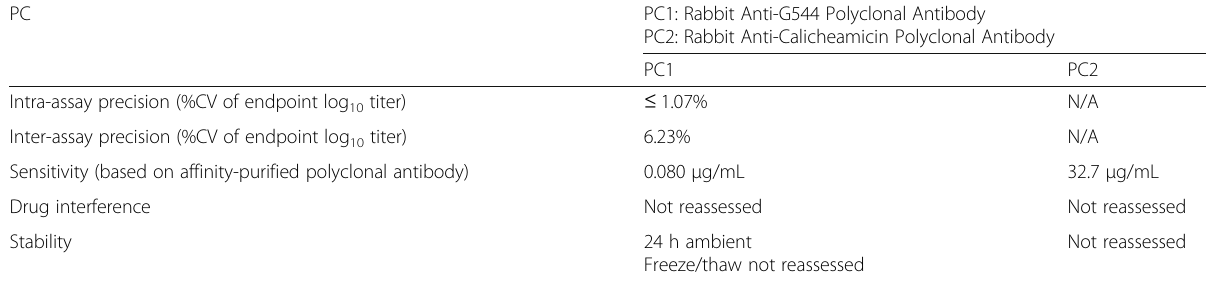
Table 5 Anti − InO antibody ELISA validation